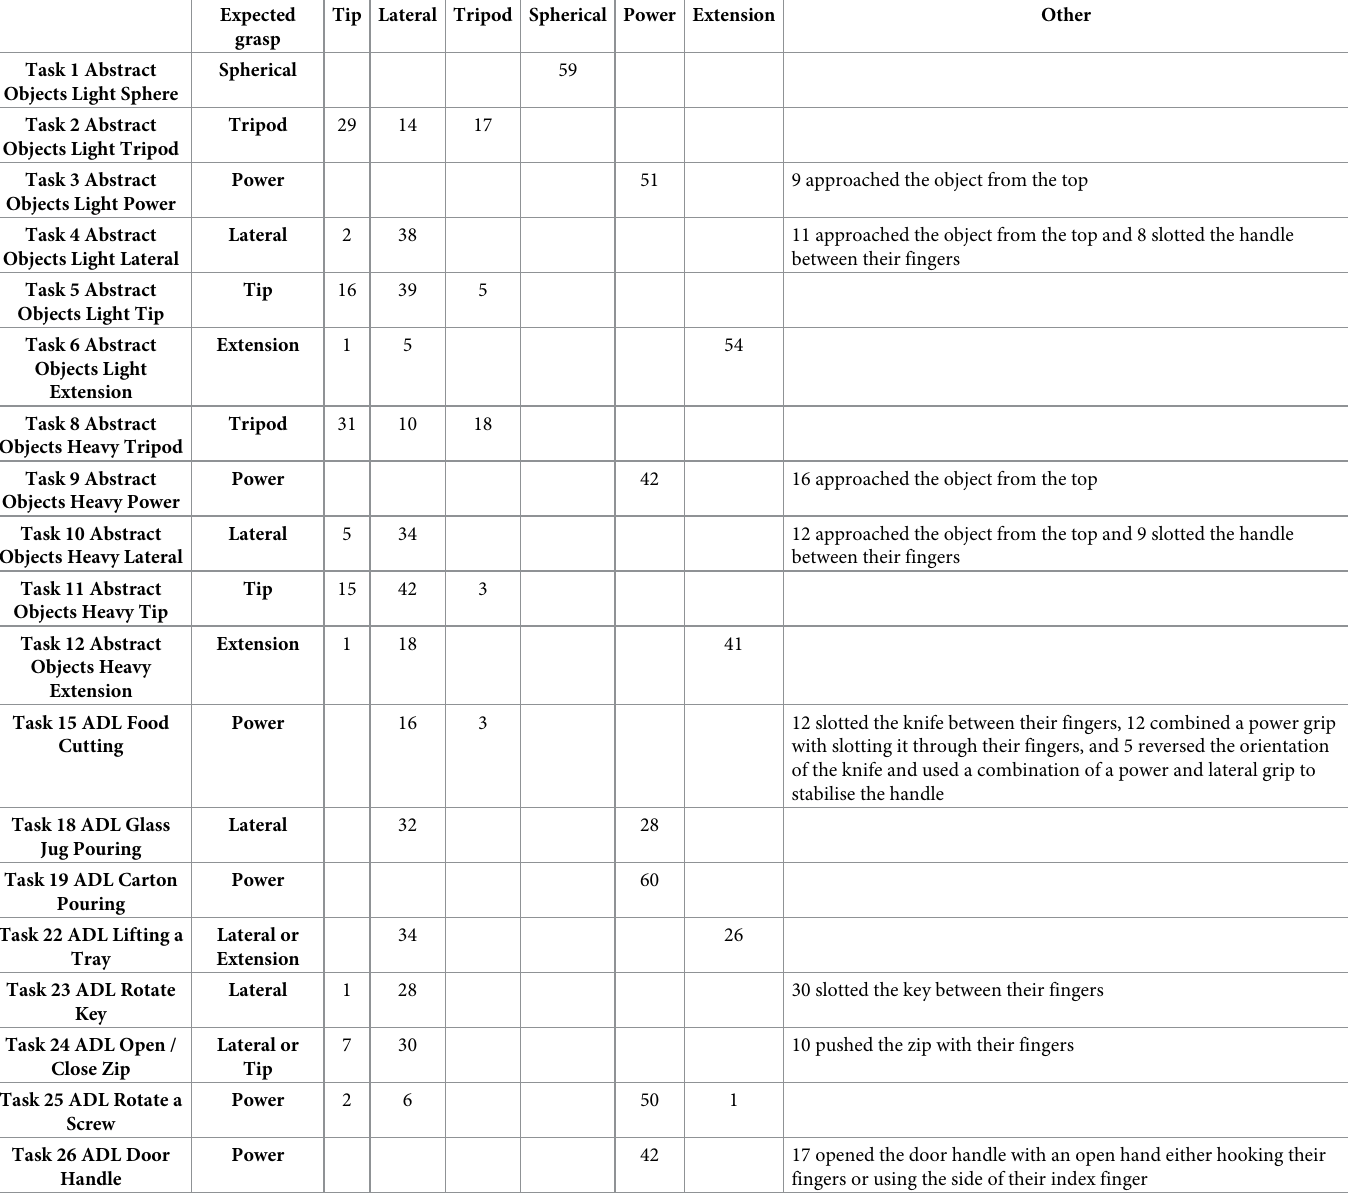
Table 3. Summary of grasps used for each